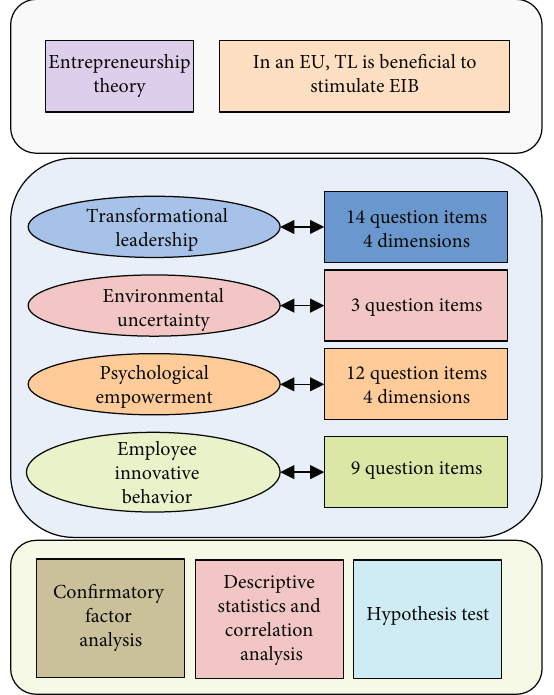
Figure 2: Research